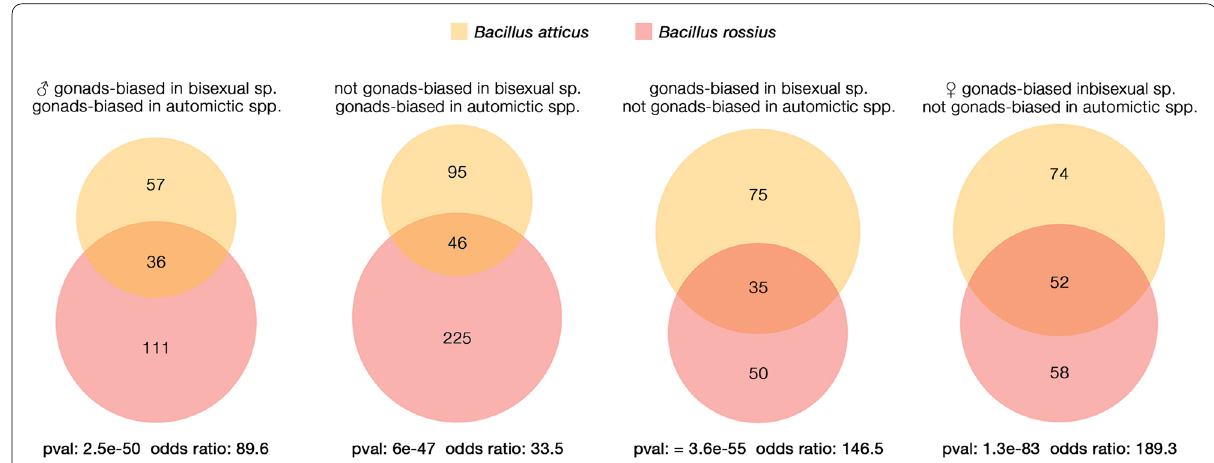
Fig. 5 Venn-diagram representation of gonads genes expression patterns in comparison to the bisexual species. Overlaps represent parthenogens’ genes with a shared pattern in the two parthenogens, for which Fisher’s exact test has been used to determine p and odds ratio in comparison to the genomic background ( n =